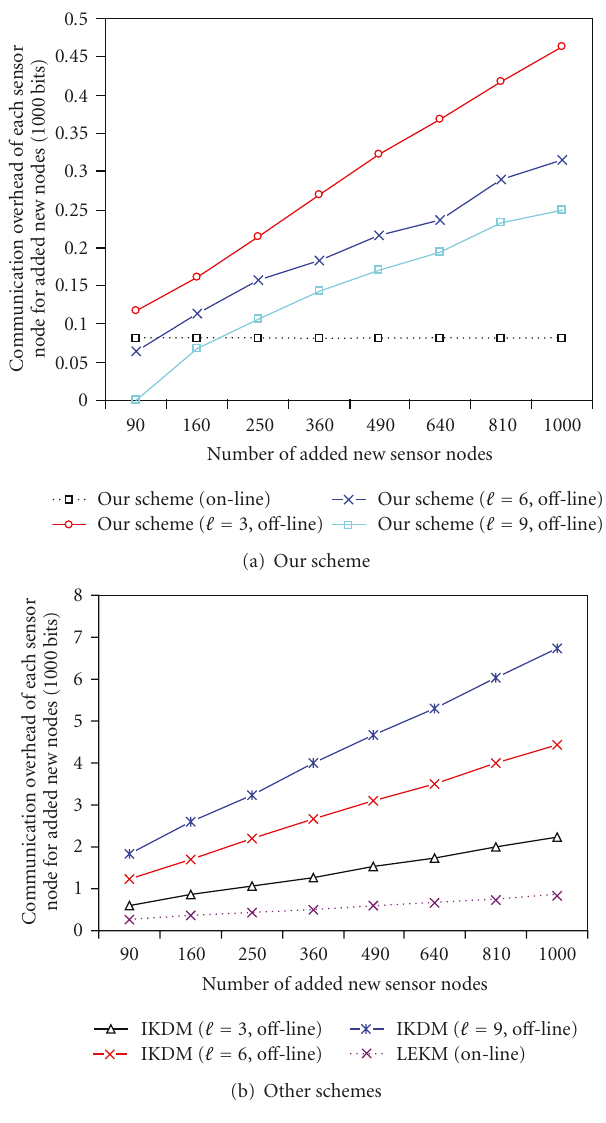
Figure 6: Communication overhead comparison.